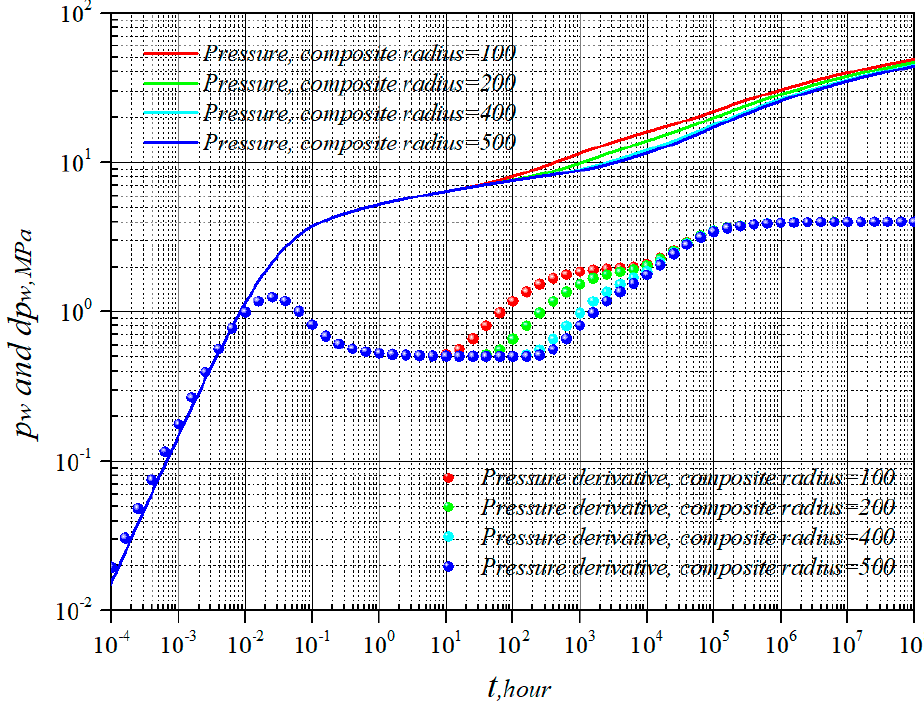
Figure 9. Effect of composite radius on the tested well’s pressure behaviors in the multi-well system.